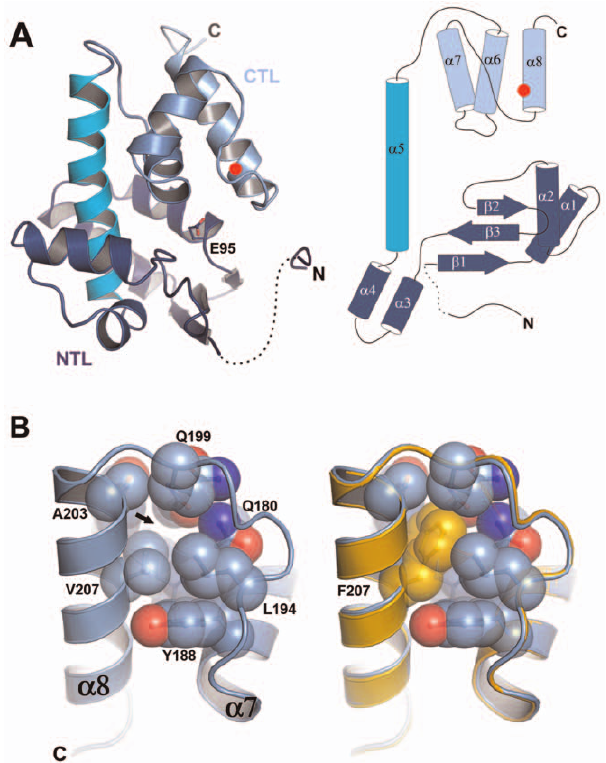
Figure 3. P5 adopts a lysozyme fold and the V207F mutation fills a cavity. A) P5 adopts a lysozyme superfamily fold with an N- terminal lobe (NTL, in dark blue) and a C-terminal lobe (CTL, light blue) connected by a central helix (cyan). The predicted catalytic residue Glu95 lies in the substrate binding cleft between the two lobes. The NTL differs from other lysozyme structures in its overall organization and relative orientation to the CTL. The three N-terminal residues of P5 form an unusual crystal packing interaction. Residues 53–59 are disordered (dashed line). Residue 207 is marked with a red circle. B) Close-up of residue 207. The Phe207 side chain in P5 D V8 V207F (orange) fills a cavity (marked by an arrow) that is unoccupied in P5 D V8 wt (light blue), with no significant changes in the protein backbone (see also Figure